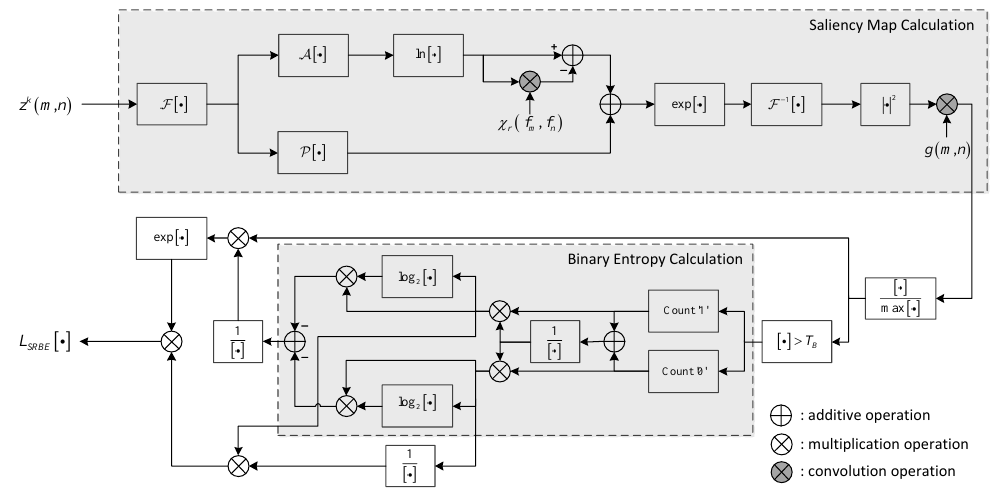
Figure 3. Flowchart of SRBE likelihood ratio